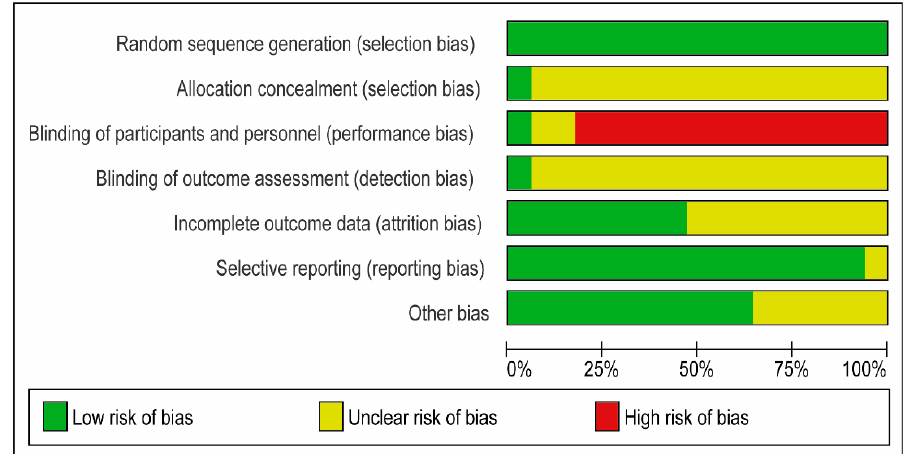
Figure 3. Risk of bias graph: review authors’ judgements about each risk of bias item presented as percentages across all included studies.